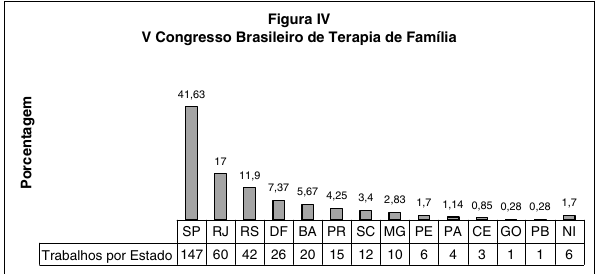
Figura 4. IV Congresso Brasileiro de Terapia de Família.